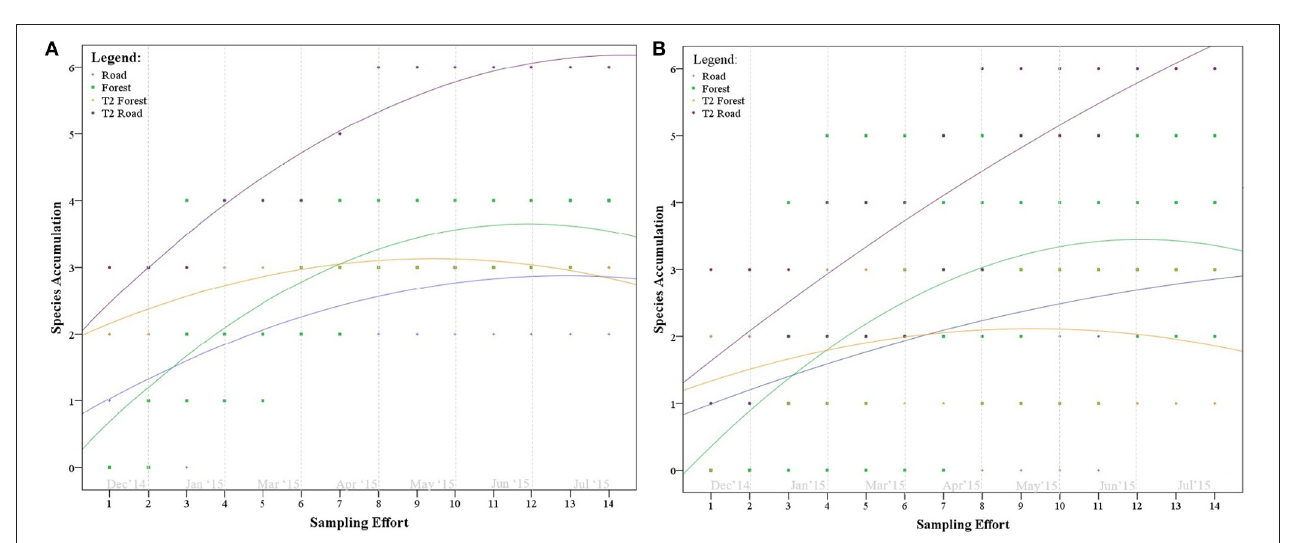
FIGURE 5 | Species accumulation graph comparing detectability and species richness at the roadside and forest ends of each transect (15m radius) in (A) Karawatha Forest and (B) Kuraby Bushland.